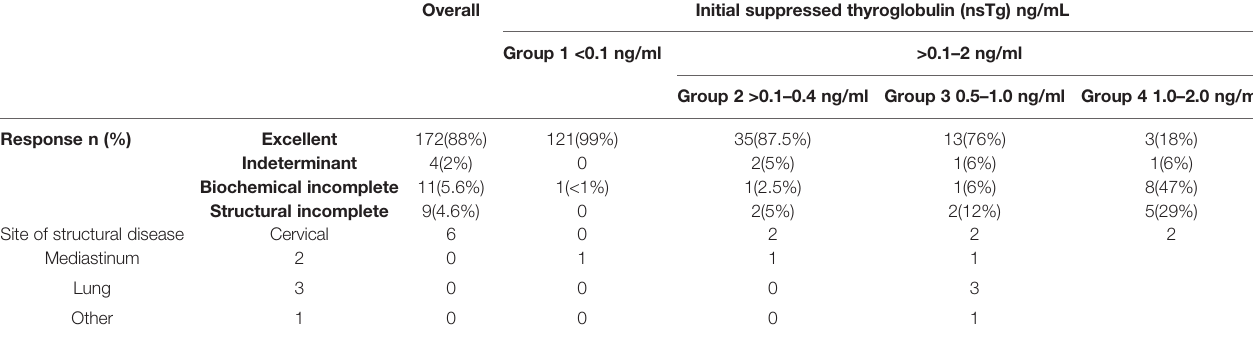
FIGURE 2 | Initial suppressed thyroglobulin and stimulated thyroglobulin done 3 – 6 months following the radioactive iodine (RAI) ablation. Patients were grouped according to non-stimulated thyroglobulin. (A) Serum thyroglobulin levels before and after recombinant human TSH (rhTSH) stimulation in 122 patients had initial (nsTg) < 0.1 ng/ml. sTg, stimulated thyroglobulin; nsTg, serum non-stimulated thyroglobulin. (B) Serum thyroglobulin levels before and after recombinant human TSH (rhTSH) stimulation in 40 patients had initial (nsTg) 0.1 – 0.4 ng/ml. sTg, stimulated thyroglobulin; nsTg, serum non-stimulated thyroglobulin. (C) Serum thyroglobulin levels before and after recombinant human TSH (rhTSH) stimulation in 17 patients had initial (nsTg) 0.5 – 1.0 ng/ml. sTg, stimulated thyroglobulin; nsTg, serum non- stimulated thyroglobulin. (D) Serum thyroglobulin levels before and after recombinant human TSH (rhTSH) stimulation in 17 patients had initial (nsTg) 1.1-2.0 ng/ml. sTg, stimulated thyroglobulin; nsTg, serum non-stimulated TABLE 3 | Clinical response of the patients. Overall Initial suppressed thyroglobulin (nsTg) ng/mL